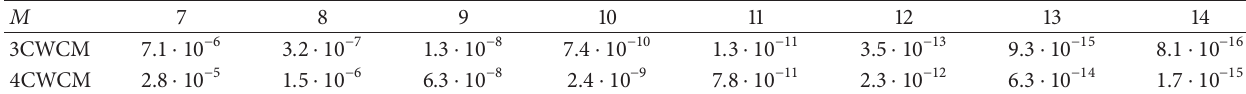
Table 8: The maximum absolute error 𝐸 for Example